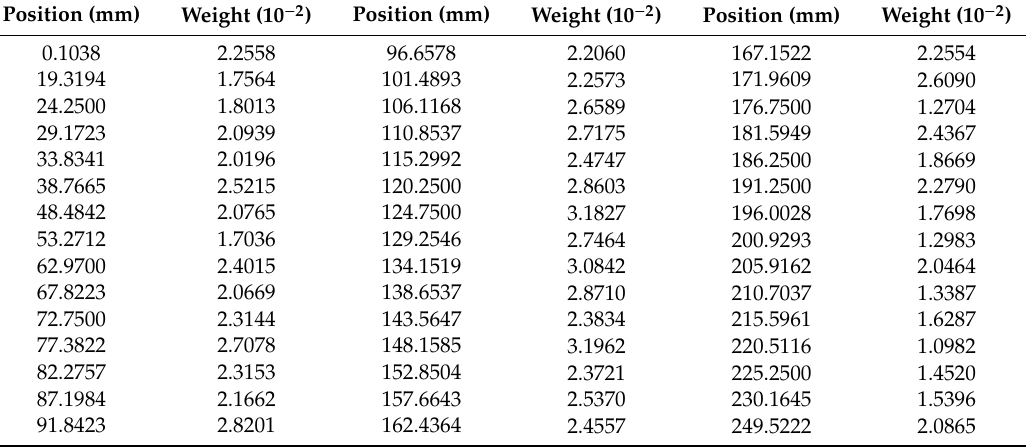
Table A1. Positions and weight values of the sparse transmitting array at 300 kHz in the